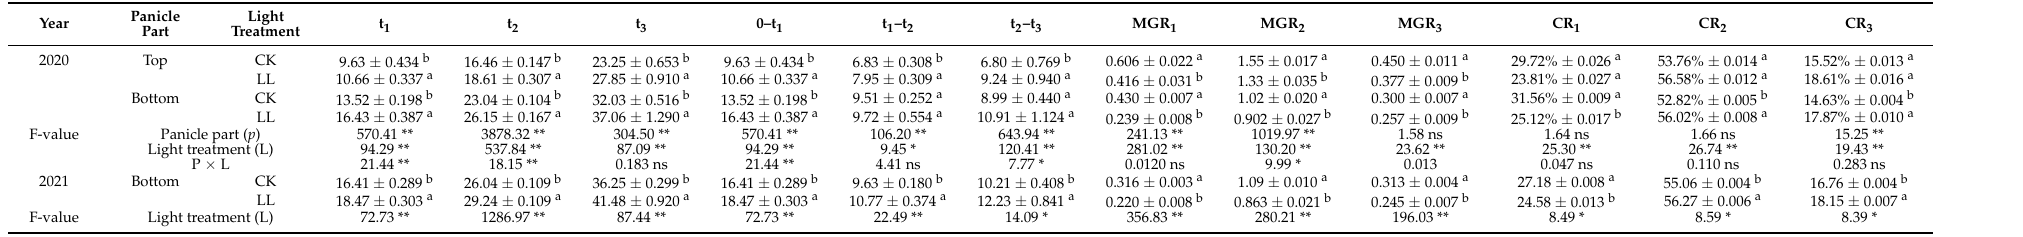
Table 4. Grain filling characteristics at different stages and panicle